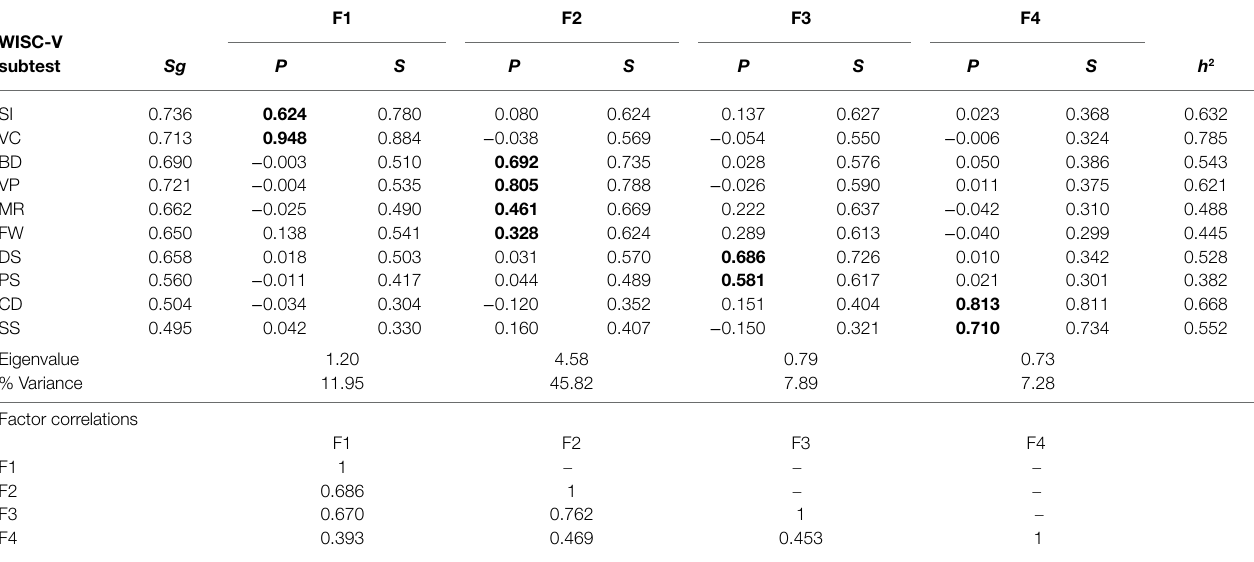
TABLE 3 | Exploratory factor analysis of the 10 WISC-V primary subtests: four-factor model solution (oblique) with promax rotation for the EFA sample ( n = 823).